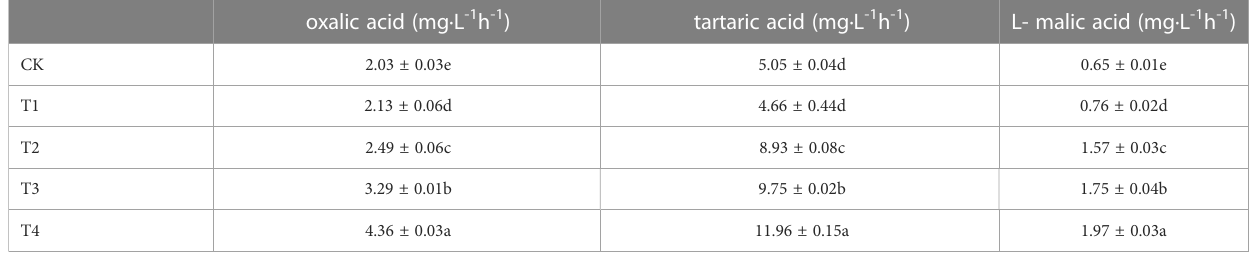
TABLE 4 Effects of different Si treatments on the organic acids concentrations in root exudates of S. alfredii